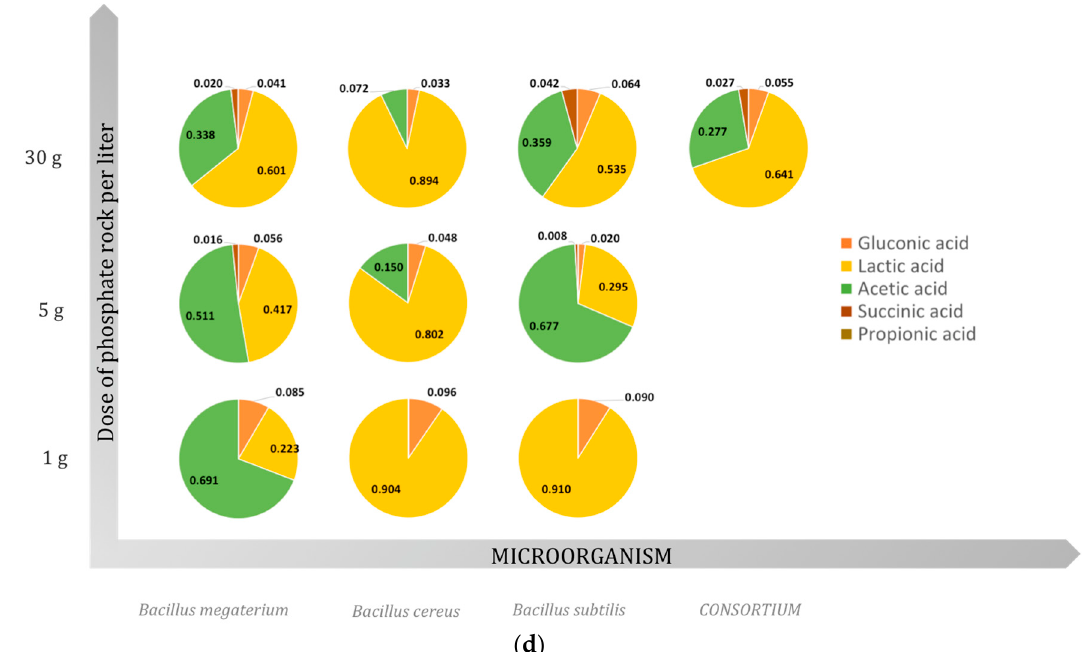
Figure 1. Contribution (mass fraction) of individual acids in relation to the obtained spectrum of organic acids (mg/L) in a microbial broth of Bacillus species in solubilization performed with the utilization of four sources of phosphorus ( N = 3): ( a ) poultry bones; ( b ) fish bones; ( c ) ash; ( d ) phosphate rock.